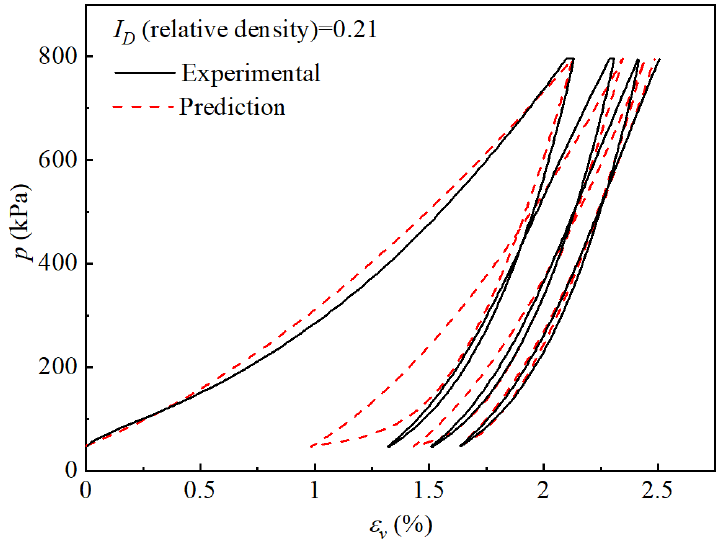
Figure 7. Pressure dependency of ( a ) bulk elastic modulus and ( b ) bulk plastic modulus .